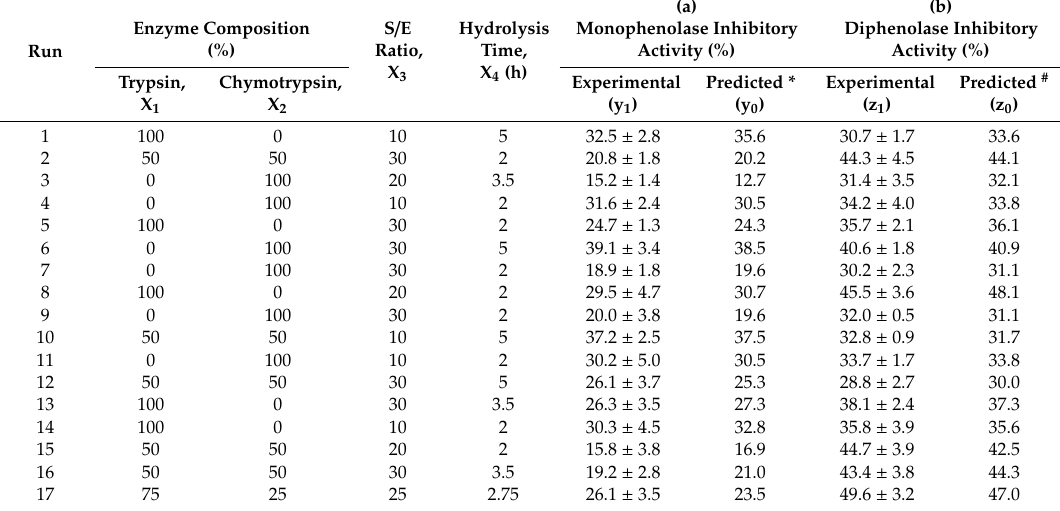
Table 2. Crossed D-optimal experimental design with the actual and predicted responses for ( a ) monophenolase and ( b ) diphenolase inhibitory activities.